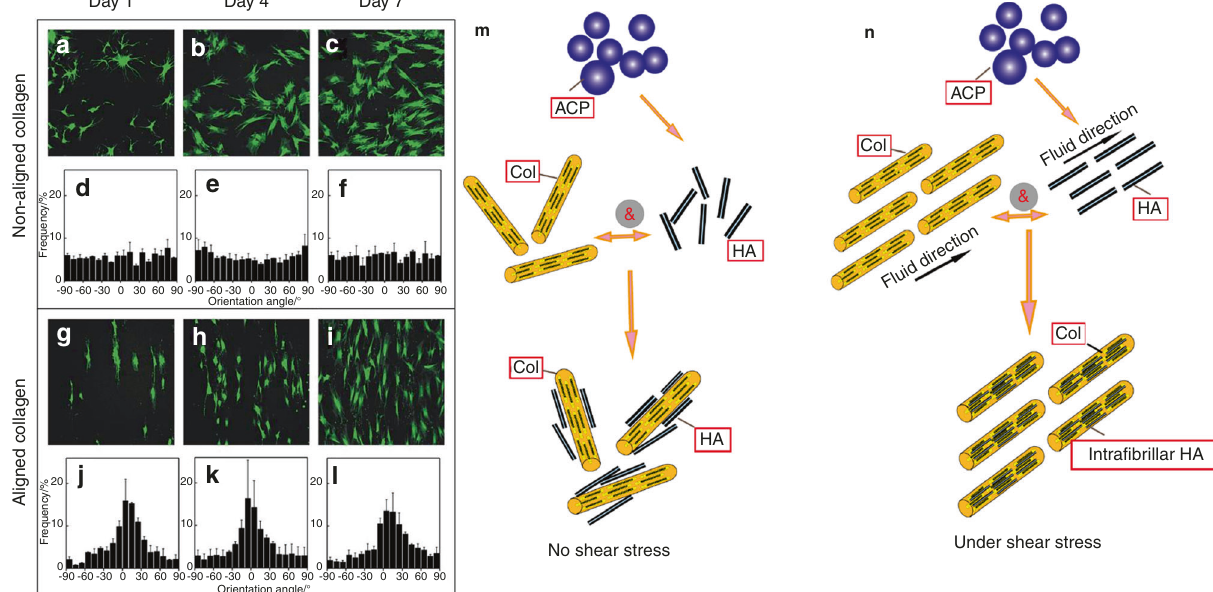
Fig. 11 Effect of mechanical stimulation on the interaction between bone-related cells, Col and HA. a – l In fl uence of aligned and randomly aligned ECM structures on cell morphology and orientation 154 . Viable mesenchymal stem cells (green) adopting random and oriented morphologies on nonaligned ( a – c ) and aligned Col ( g – l ) on Days 1, 4, and 7. Quanti fi cation of cell orientation angles with the corresponding images is shown in the panels below ( d – f , j – l ). (Scale bar: 200 μ m; ±s.d., n = 4 replicates from two different donors). m , n Effects of FSS on Col/ HA mineralization. Col is a template for mineralization, and HA crystals grow along the long axis of Col fi brils. FSS can promote ACP precursor transformation into HA crystals and improve the crystallization and orientation of HA. Figures adapted with permission from ref.